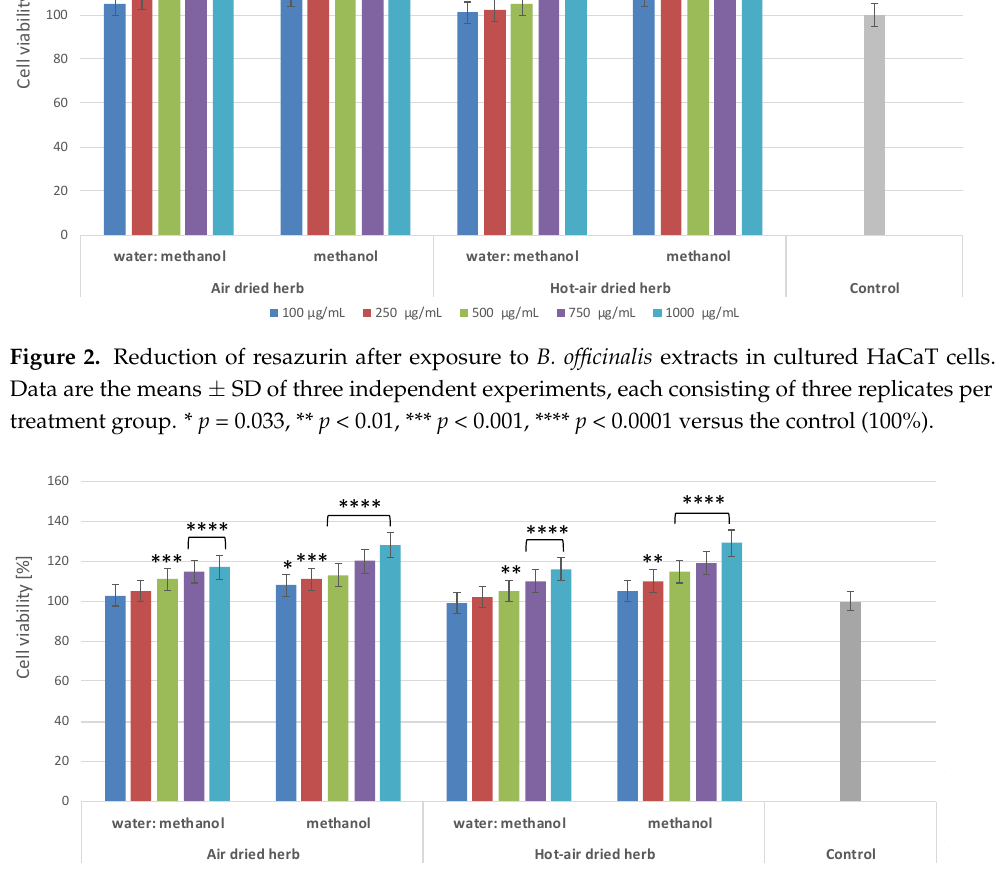
Figure 3. Reduction of resazurin after exposure to B. officinalis extracts in cultured fibroblasts. Data are the means ± SD of three independent experiments, each consisting of three replicates per treatment group. * p = 0.065, ** p < 0.01, *** p < 0.001, **** p < 0.0001 versus the control (100%).